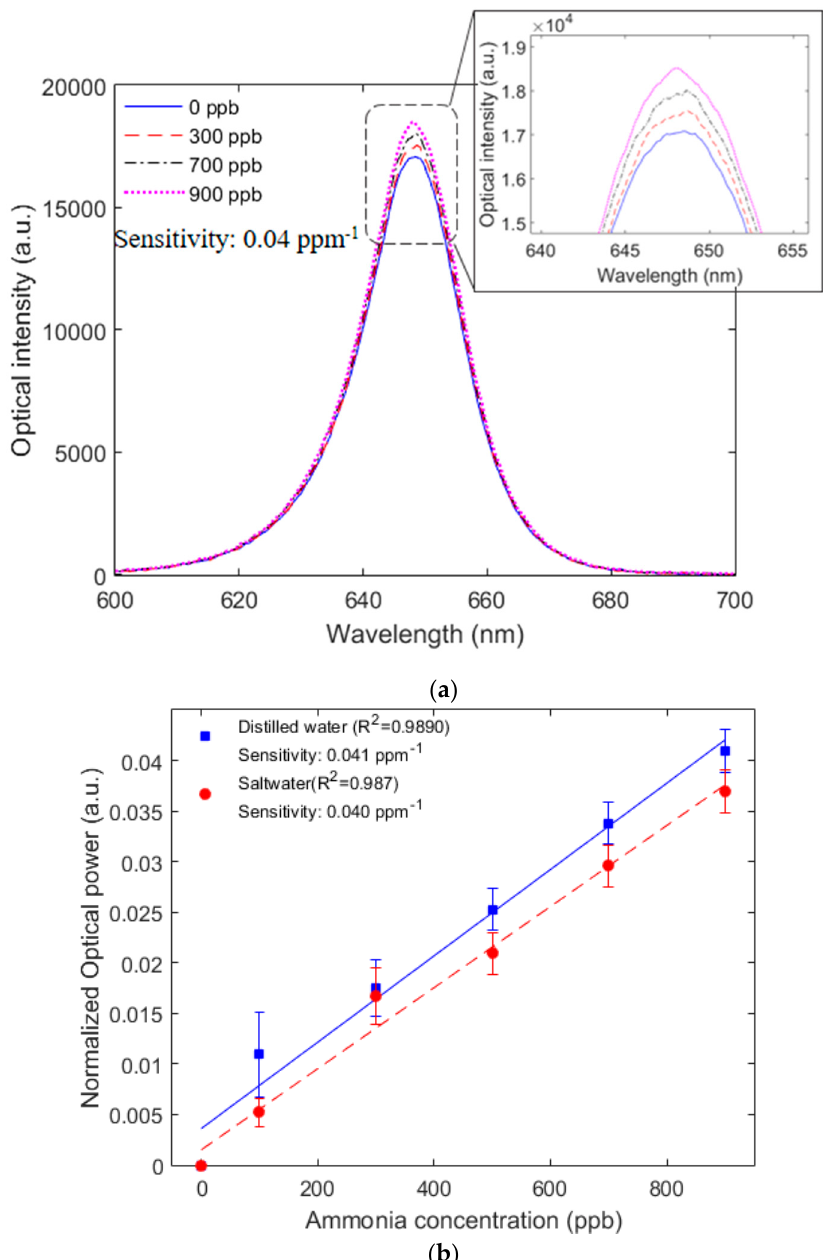
Figure 7. ( a ) Fiberoptic probe reflected spectra for different ammonia concentrations in high-salinity water. ( b ) Comparison between the sensors responses as a function of the ammonia concentration in distilled water and saltwater.